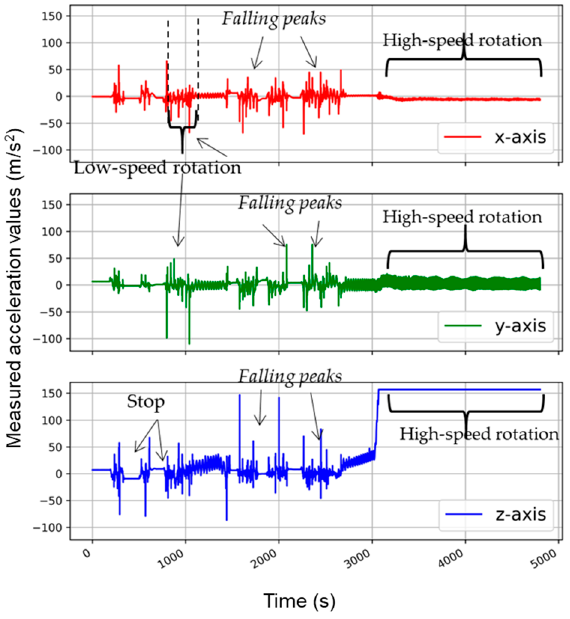
Figure 8. Accelerometer analysis in the tumbling phase at 600 RPM.